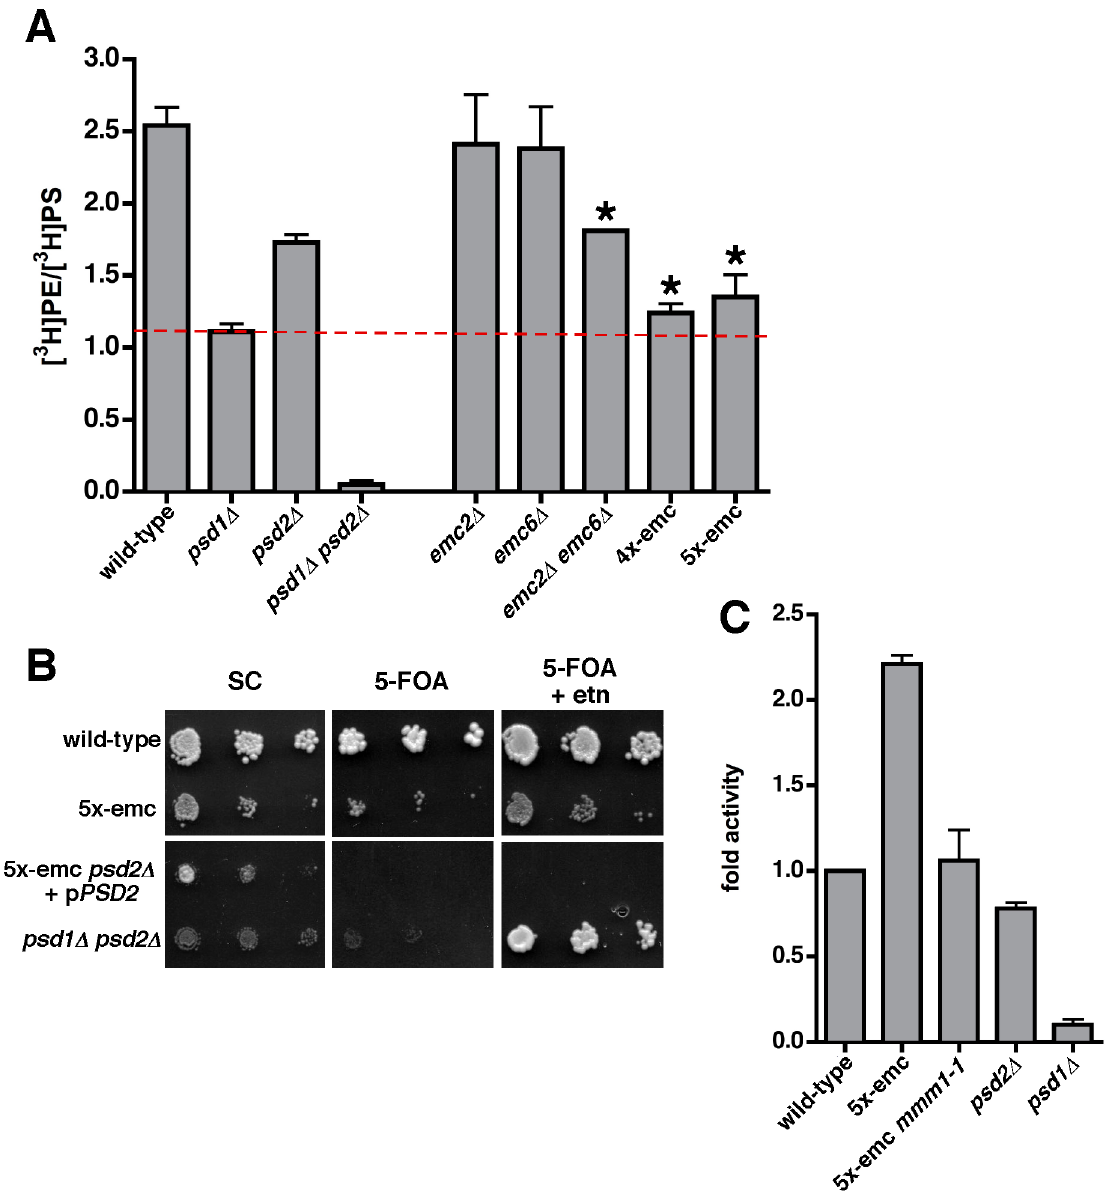
Figure 4. Cells missing multiple EMC proteins have defects in PS transfer from the ER to mitochondria. (A) Cells with the indicated genotypes were labeled with [ 3 H]serine for 30 min and the ratio of [ 3 H]PS converted to [ 3 H]PE determined (mean 6 s.d., n =3–5 independent experiments). The dashed red line indicates the amount of conversion that occurred in psd1 D cells. * p , 0.05 compared to wild-type, independent two-tailed t test. (B) The 10-fold serial dilutions of cultures of the indicated strains were spotted onto SC medium with or without 5-FOA and ethanolamine. The plates were incubated at 30 u C for 4 d. (C) PSD activity of crude mitochondria incubated with NBD-PS for 1 h at 30 u C. PSD activity was normalized to that of wild-type crude-mitochondria (mean 6 s.d., n =2–3 independent experiments). * p , 0.05 compared to wild-type, independent two-tailed t test. The data used to generate panels A and C are in Table S4.